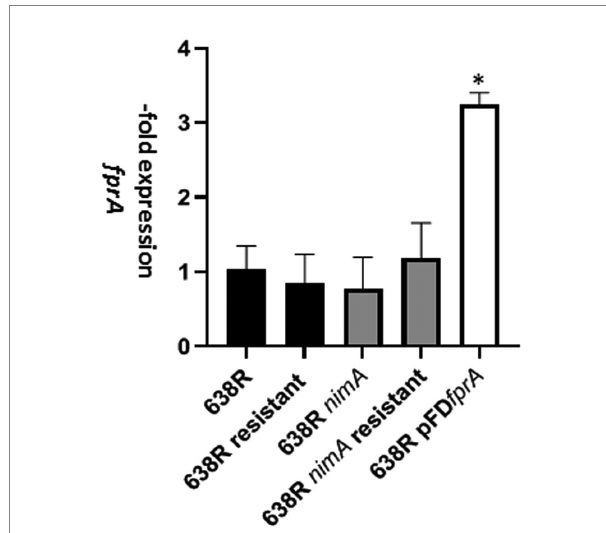
FIGURE 2 Levels of fprA mRNA as determined by RT-qPCR in 638R, 638R R , 638R nimA , 638R nimA R , and 638R pFD fprA which carries an additional copy of the fprA gene on shuttle plasmid pFD340 under transcriptional control of insertion element 4351 (IS 4351 ). Measurements were performed in three independent experiments each. The asterisk indicates 638R pFD fprA > 638R with p < 0.001 according to Brown-Forsythe and Welch ANOVA tests with a post- hoc two stage linear step-up procedure of Benjamini, Krieger, and Yekutieli.